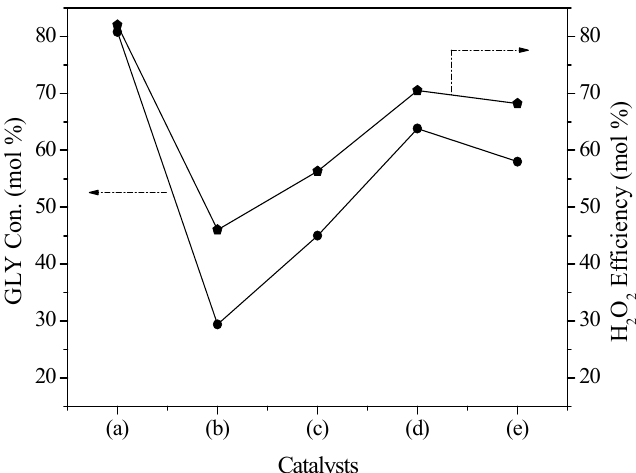
Figure 5. The GLY conversion and H 2 O 2 efficiency over different catalysts: ( a ) LDH-[Cr(SO 3 -salphen)], ( b ) LDH-[Mn(SO 3 -salphen)], ( c ) LDH-[Fe(SO 3 -salphen)], ( d ) LDH-[Co(SO 3 -salphen)], ( e ) LDH-[Cu(SO 3 -salphen)] Efficiency of H 2 O 2 = (moles of H 2 O 2 converted to the products/moles of H 2 O 2 consumed) × 100.